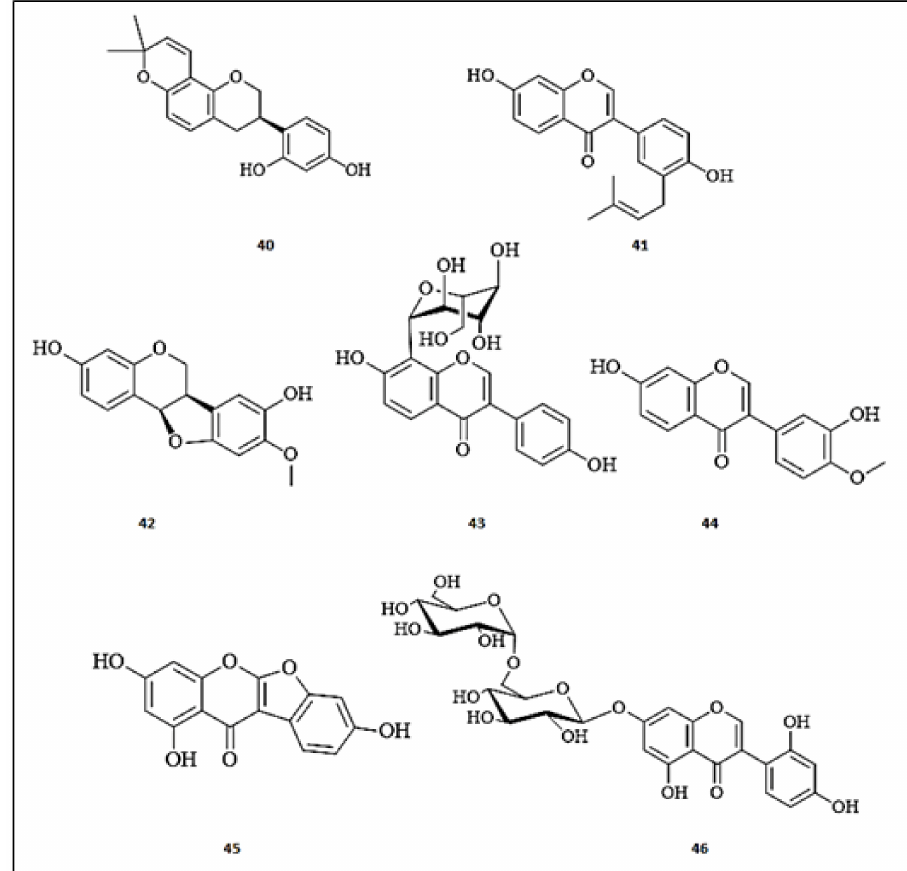
Figure 4. The chemical structures of isoflavones with anti-tyrosinase activity. ( 40 ) Glabridin; ( 41 ) Neobavaisoflavone; ( 42 ) (6aR,11aR)-3,8-dihydroxy-9-methoxy pterocarpan; ( 43 ) Puerarin; ( 44 ) Caly- cosin; ( 45 ) Lupinalbin A; ( 46 ) 2 (cid:48) -hydroxygenistein-7- O